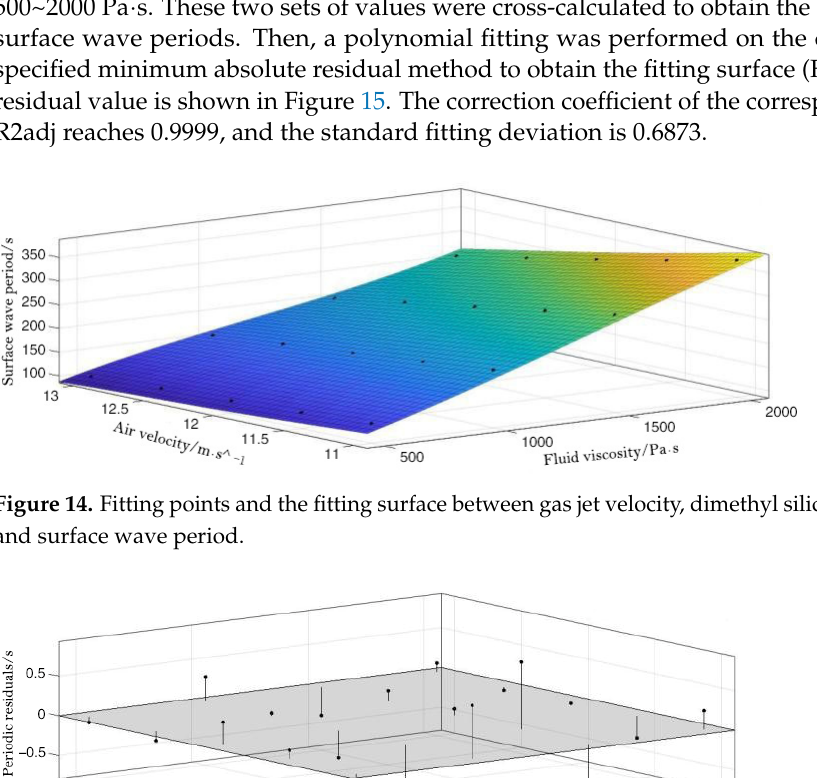
Table 9. Values of the fitting Equation (3).